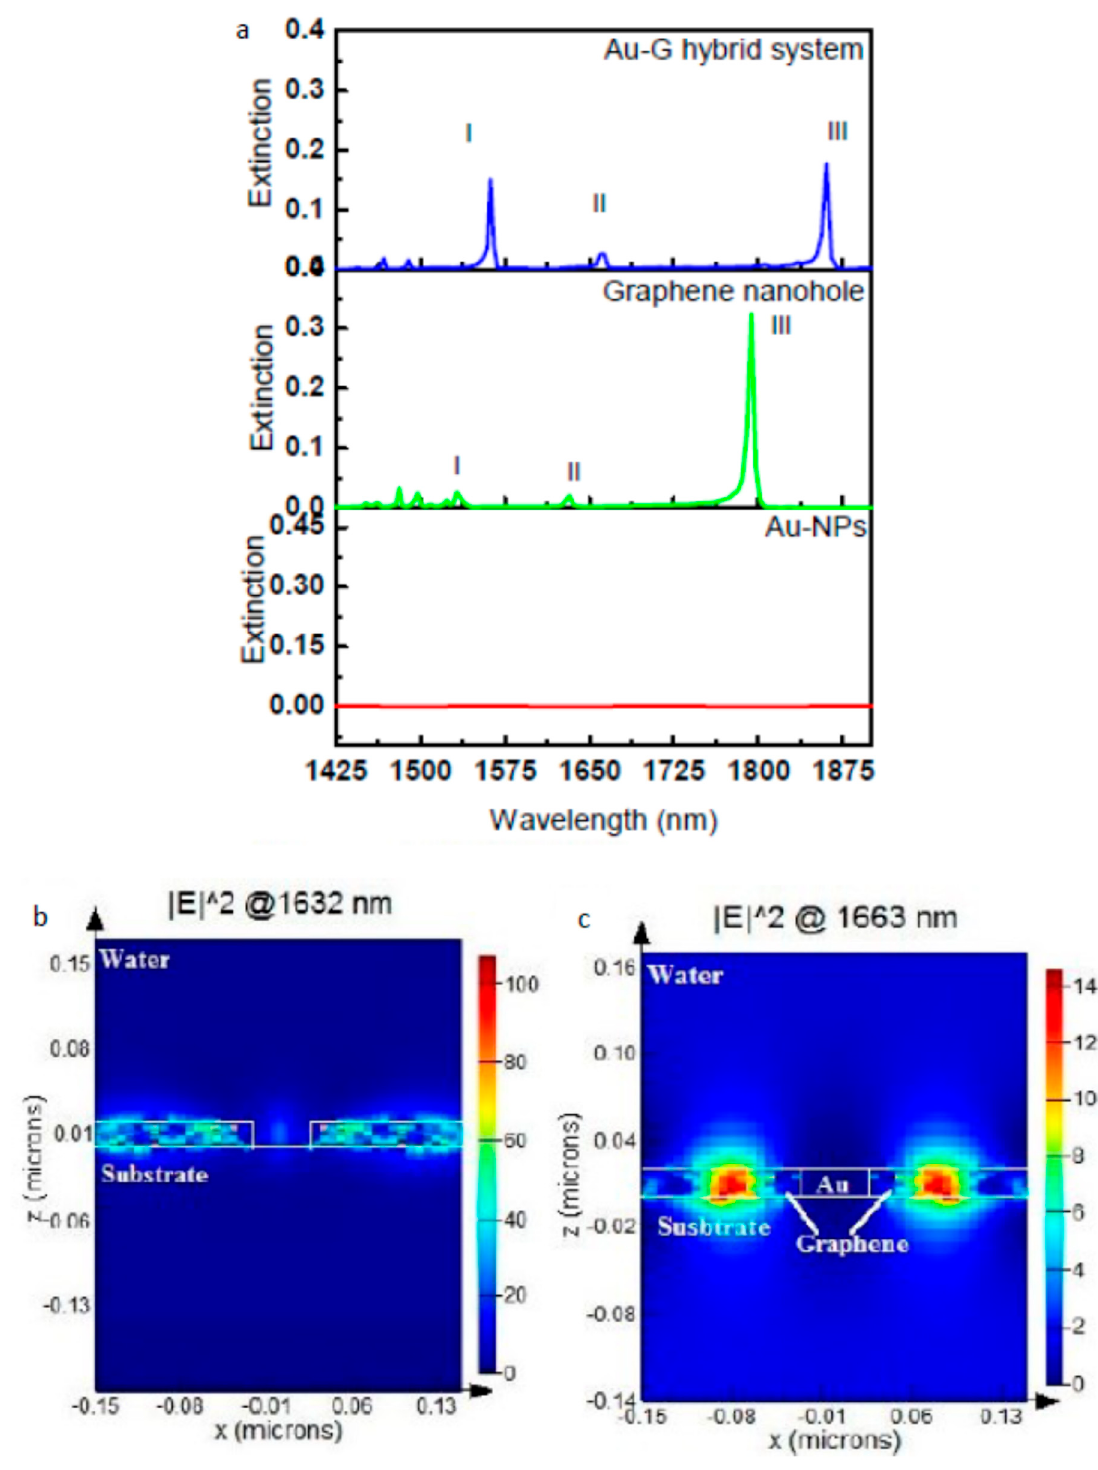
Figure 4. ( a ) Extinction spectrum for three different nanostructures; Au NP square array, nanohole array perforated in 20 nm-thick graphene film, and Au NPs/G hybrid structure showing three main resonance modes; Mode I ( λ = 1532 nm), Mode II ( λ = 1632 nm), and Mode III ( λ = 1793 nm). ( b , c ) are the electric field profiles at the resonance wavelength of Mode II for the graphene nanohole structure and the Au-graphene hybrid structure, respectively [24].